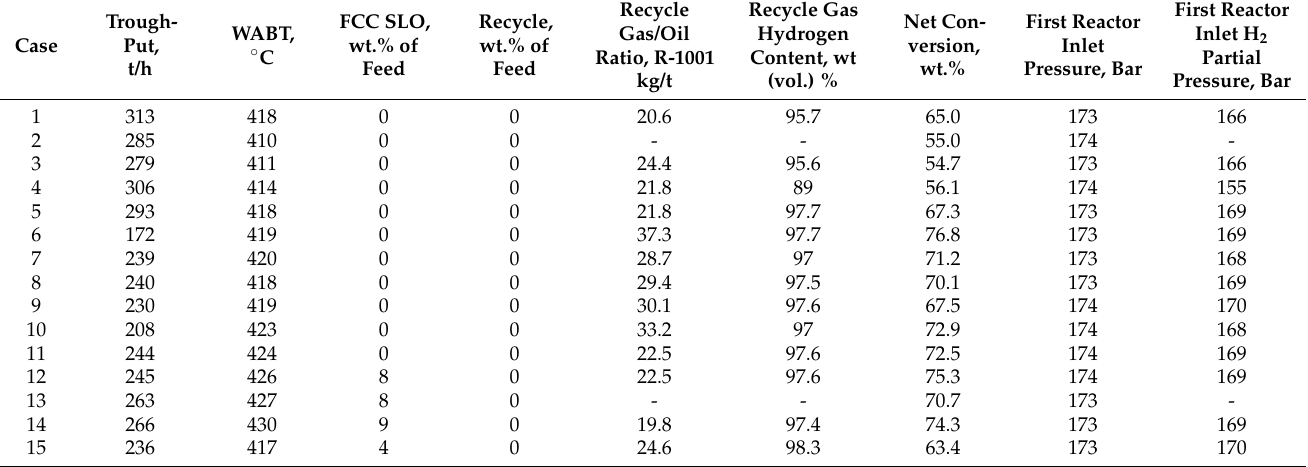
Table 5. Operating conditions in LNB H-Oil ® hydrocracker for the studied 36